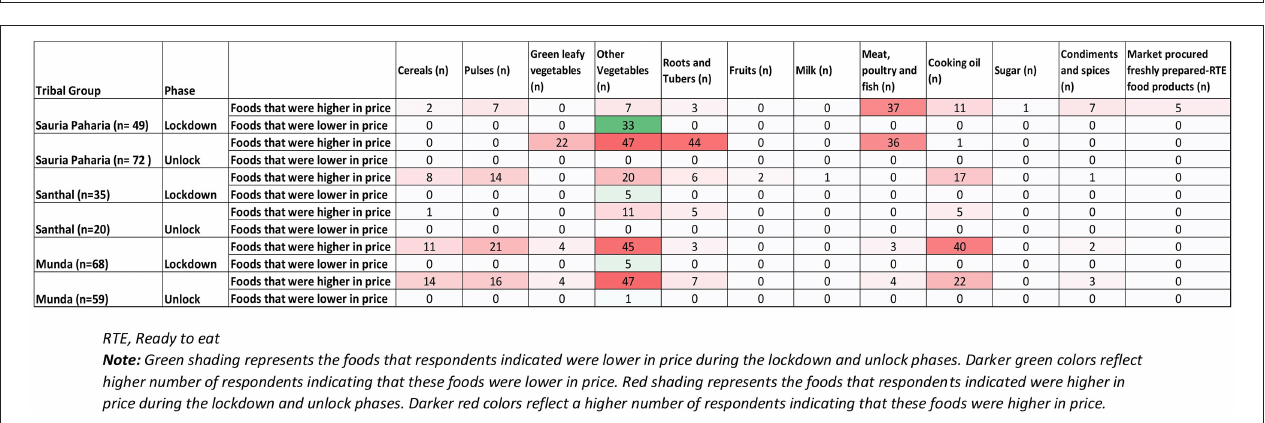
FIGURE 7 | Impact of COVID-19 pandemic on food prices in tribal regions of Jharkhand, India.